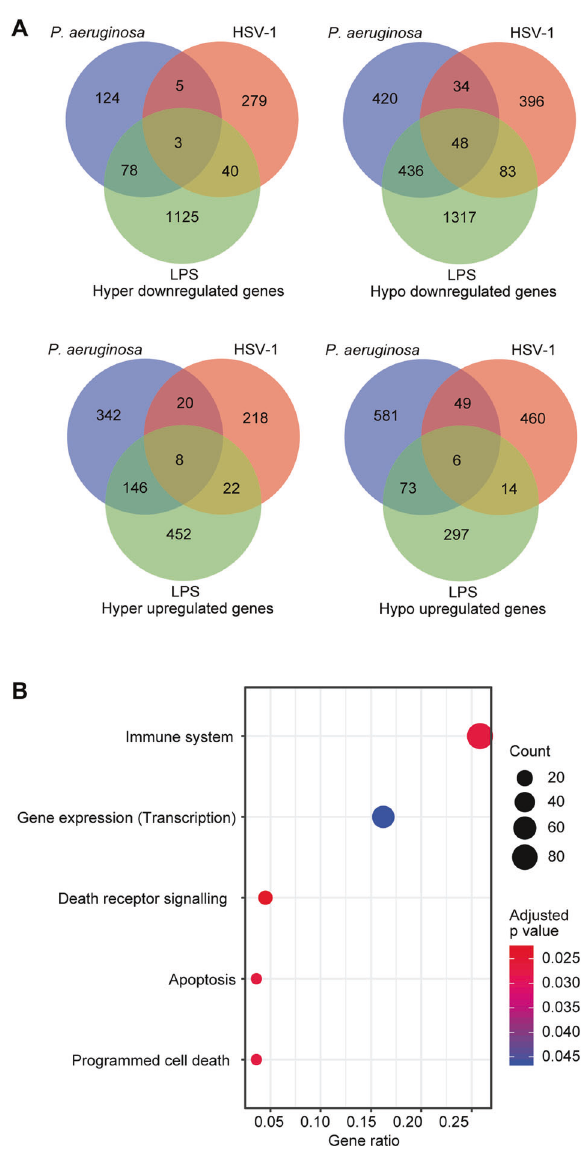
Fig. 4 Common and distinct differentially expressed and methy- lation genes following P. aeruginosa and HSV-1 infections, and LPS treatment. A Common and distinct differentially expressed and methylated genes following P. aeruginosa and HSV-1 infections as well as LPS treatment. B Enriched pathways for common differen- tially expressed and methylated genes following P. aeruginosa and HSV-1 infections, or LPS treatment and HSV-1